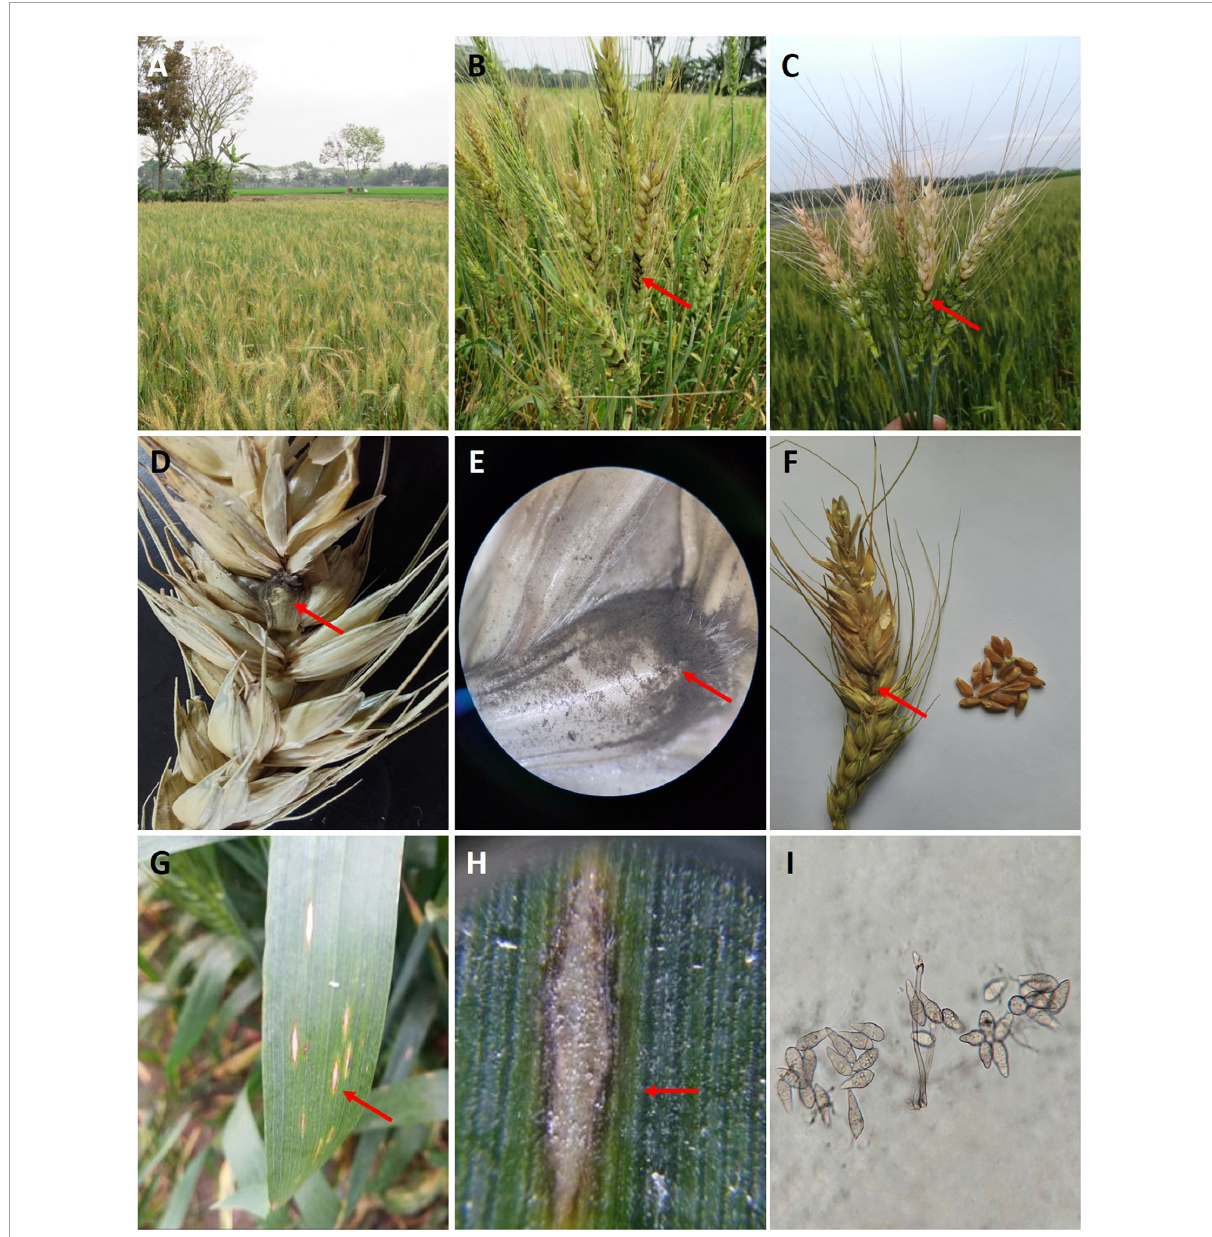
FIGURE3 Infected wheat plants showing typical wheat blast symptoms and signs. (A) A severely blast infected wheat field showing silvery bleached spikes with green canopies in Meherpur District in Bangladesh. (B) Wheat blast symptoms on wheat heads having dark-colored infection points. (C) Typical partial or full bleached spikes in the field. (D) Dark-gray sporulation of the fungus MoT on the blighted rachis. (E) Infected glume with dark-gray sporulation of the fungus MoT . (F) Severely shriveled or wrinkled wheat grains from the blast-affected spike. (G) Typical elongated or elliptical lesions on wheat leaves. (H) A typical elliptical lesion with white to tan centers and a reddish-brown margin on a mature leaf. (I) Two-septate hyaline to pale gray-colored pyriform conidia of MoT under a compound microscope (magnification 400 ×